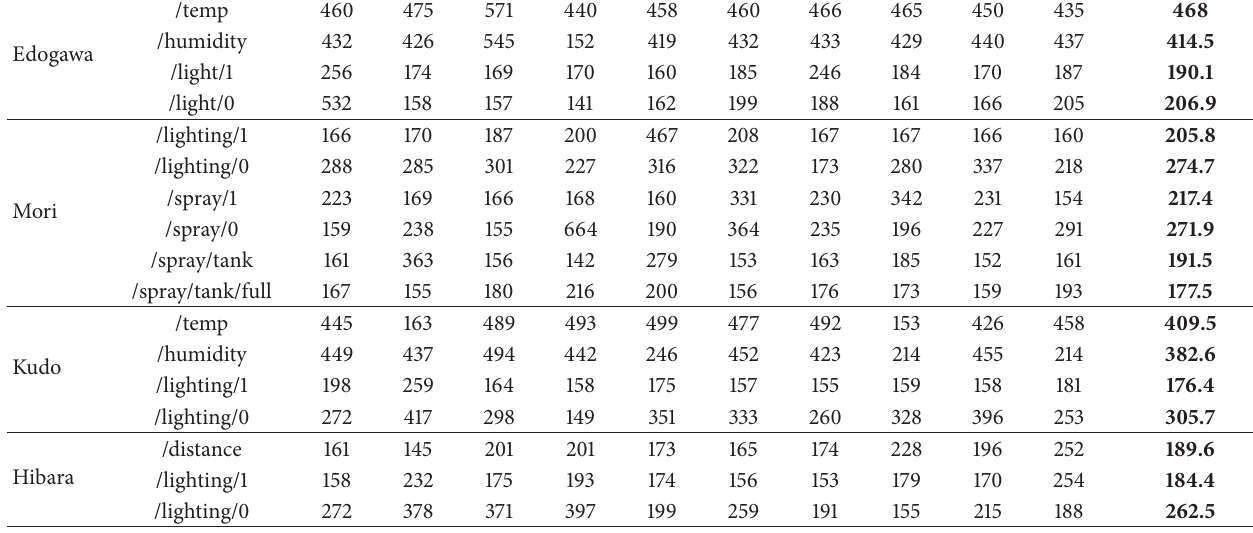
Table 3: Response times for UAV resources